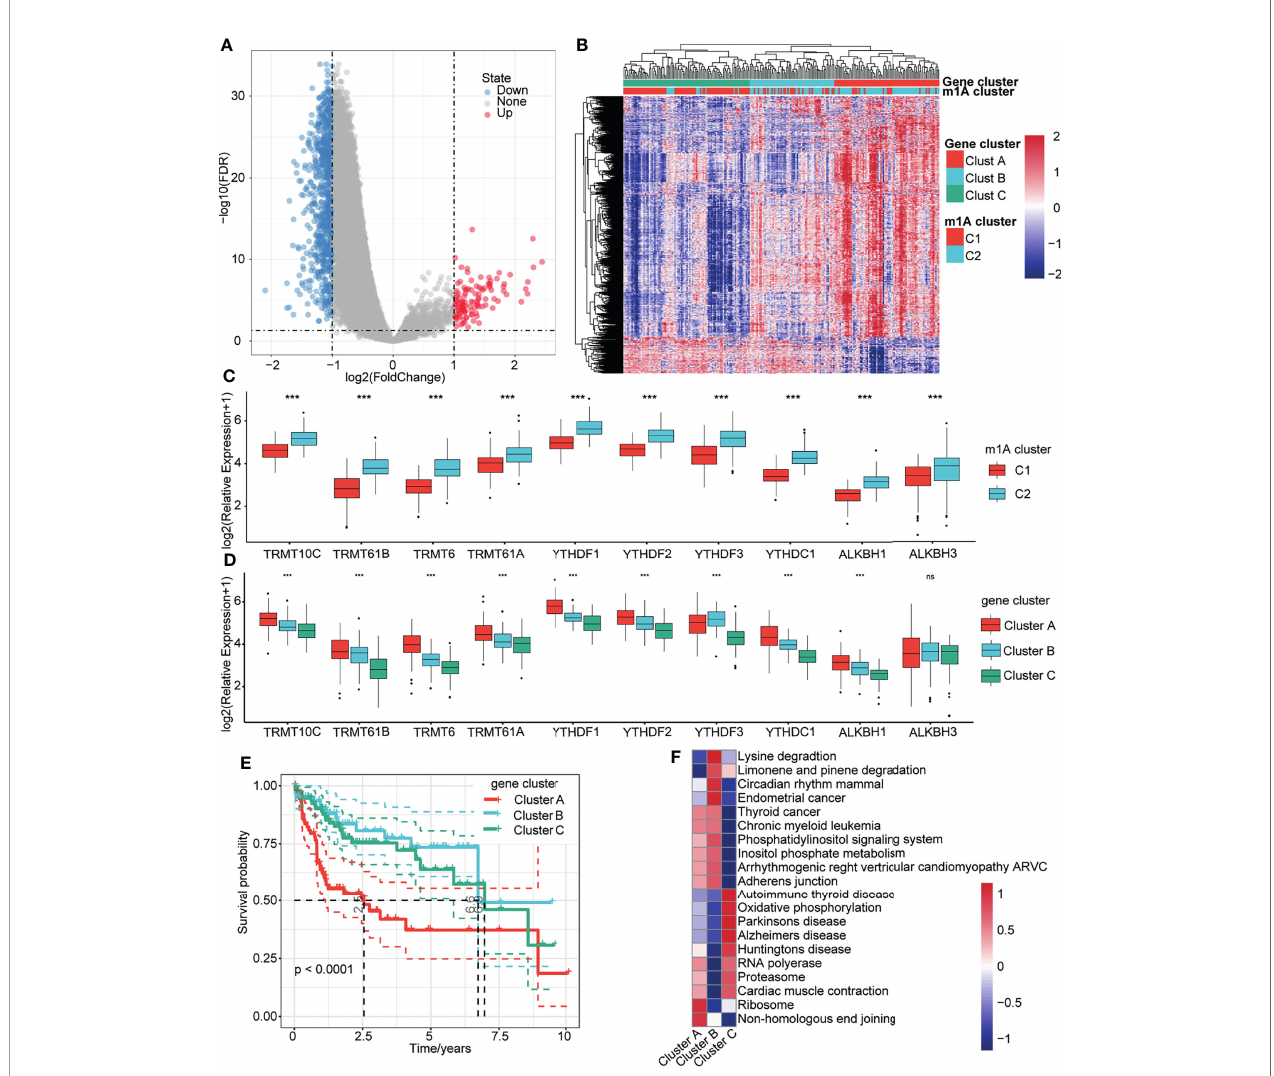
FIGURE 4 | Gene clusters related to m1A modi fi cation patterns. (A) Volcano map of the DEGs in m1A Clusters C1 and C2. (B) Heatmap of m1A-related DEG unsupervised clustering. (C) Distribution of 10 m1A regulator genes in C1 and C2. (D) Distribution of 10 m1A regulator genes in gene clusters A, B, and C. (E) Overall survival differences among the three gene clusters. (F) Enrichment pathways of the three gene clusters. ***P < 0.001; ns,